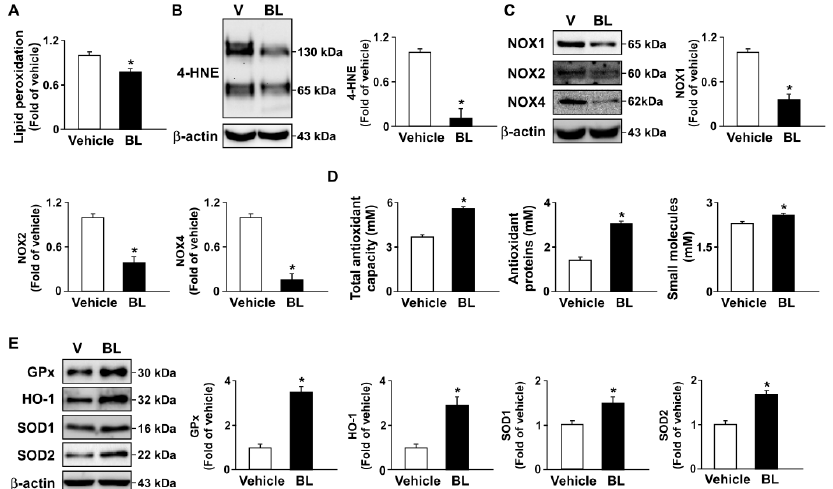
Figure 6. Bromelain decreases oxidative stress by increasing antioxidant capacity in the livers of apoe −/− mice. Male apoe −/− mice were orally administered bromelain (BL, 20 mg/kg/day) or vehicle (PBS) for four weeks. ( A ) The hepatic levels of lipid peroxidation in the livers of bromelain- or vehicle-treated apoe −/− mice. ( B , C ) Western blot analysis of 4-HNE, NOX1, NOX2, NOX4, and β -actin. ( D ) The levels of total antioxidant capacity, antioxidant proteins, and small molecules. ( E ) Western blot analysis of GPx, HO-1, SOD1, SOD2, and β -actin. * p < 0.05 vs. vehicle-treated apoe −/− mice. Moreover, similar results regarding the beneficial effects of bromelain on AMPK–TFEB pathway-mediated autophagy and antioxidant capacity were observed in the atherosclerotic aortas of apoe − / − mice (Figures 7 and 8). Together, these results indicate that the activation of the AMPK–TFEB pathway is important for the valuable effects of bromelain in regulating autophagy-mediated lipid hydrolysis and antioxidant capacity. This regulation leads to the alleviation of atherosclerosis in apoe − / − mice (Figure 9).